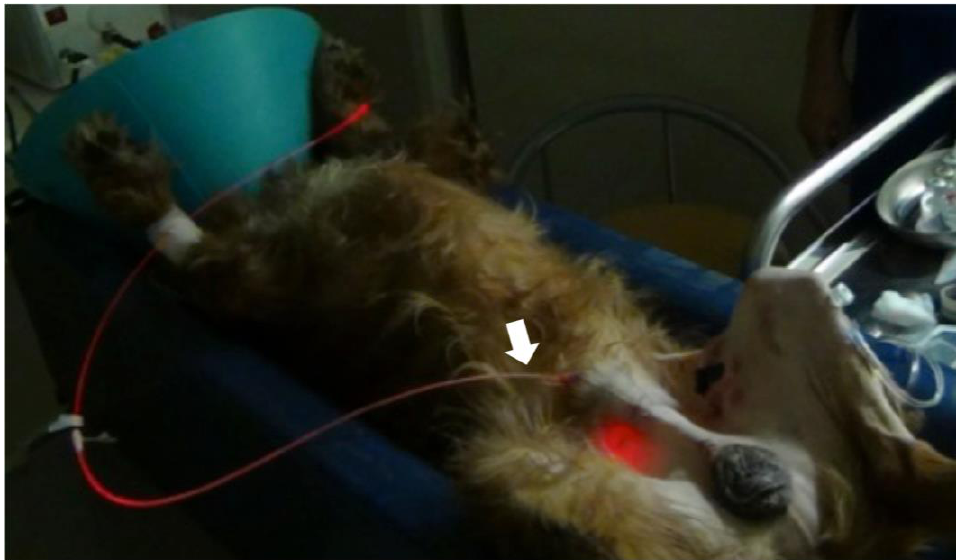
Figure 5. Photodynamic therapy and intra-arterial chemotherapy injection for case No. 11. An 11 year old, mixed-breed dog presented with hematuria and polyuria. The dog was diagnosed with transitional cell carcinoma of the lower urinary tract and treated with photodynamic therapy as in case No. 10 along with intra-arterial chemotherapy. An optical fiber placed in an 8Fr versatile catheter was inserted into the urethra (white arrow). The fiber tip was placed at the tumor site under ultrasound and the tumor was irradiated (150 mW, 270 J) under sedation.